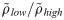
Ratio of apparent internal-to-external noise ratio at low and high performance levels.The x-axis shows the apparent internal-to-external noise ratio ρ˜low/ρ˜high for the noiseless VPPM model and the y-axis shows the same ratio for human observers in Experiment 2.